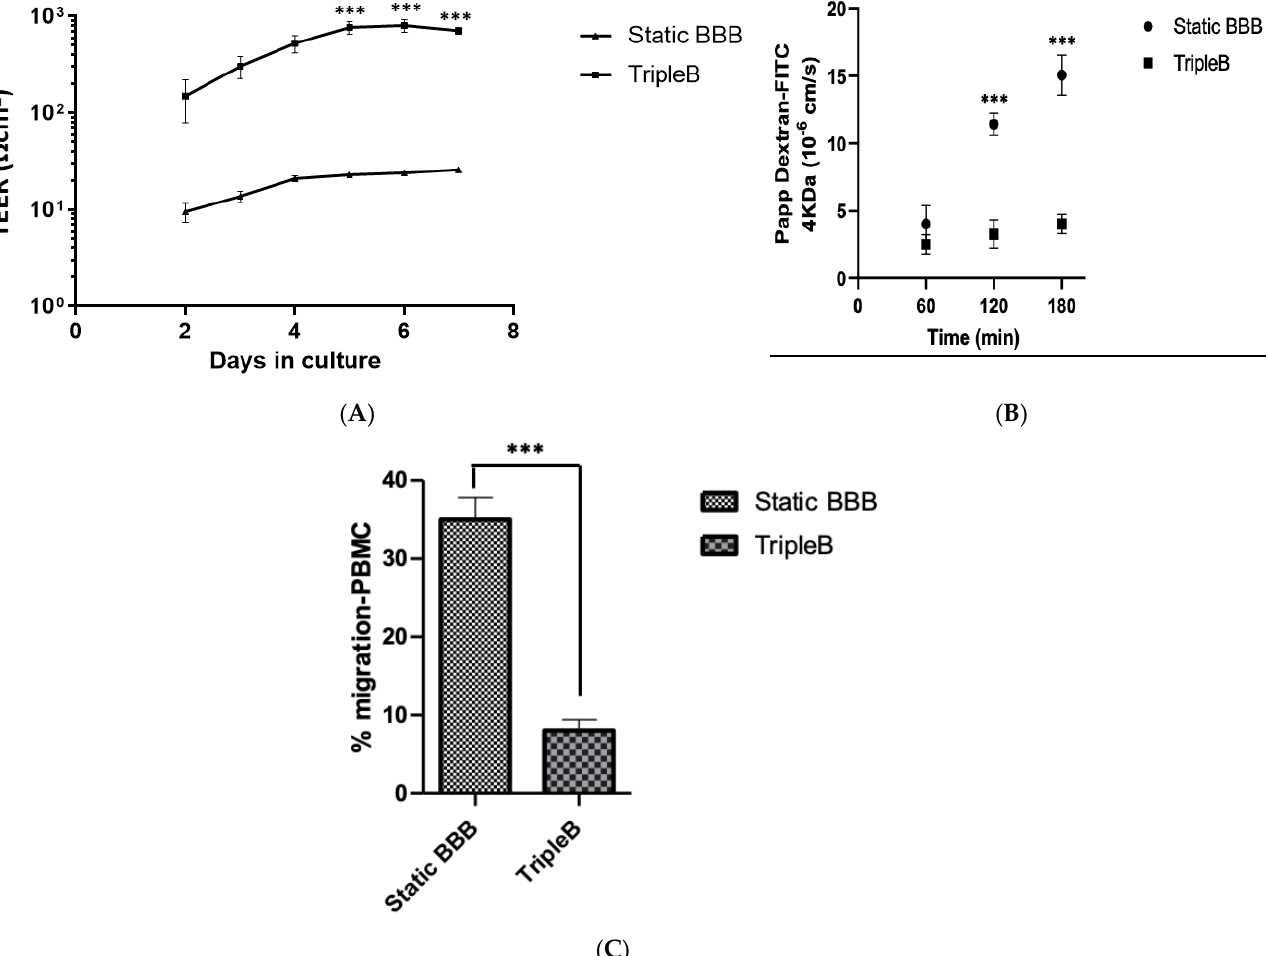
Figure 6. Highly rigorous blood–brain barrier formation takes place when the cells are cultured in the presence of flow. TEER was measured following the growth of hCMEC/D3 and astrocytes on permeable membranes ( A ) under static and dynamic (4–15 dyn/cm 2 ) conditions. The TEERs of hCMEC/D3 were measured when grown on permeable inserts in the absence and presence of shear stress. Steady-state TEER values were typically reached in the static BBB by day 4 of culture and were attained by the TripleB slides by day 5. (n = 6). Permeability to the tracer molecule FITC–dextran; ( B ) a significant decrease in the apparent permeability to FITC–dextran was induced in the BBB cultured in dynamic flow conditions as compared to the static BBBs (n = 4) ( C ) The ability of immune cells to cross the BBB was significantly downregulated under dynamic flow conditions. Migratory capacity of PBMCs was evaluated across a static and a dynamic BBB. Significantly lower numbers of PBMCs were recovered from the TripleB culture as compared to the amount of cells harvested from a static culture of BBB. (n = 4, *** p ≤